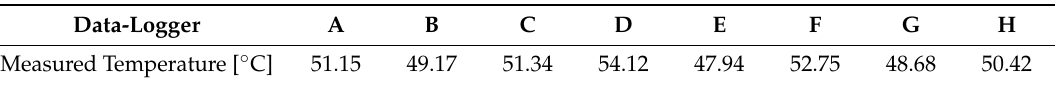
Table 7. Average temperatures recorded at data-logger locations during the last 36 h of heat